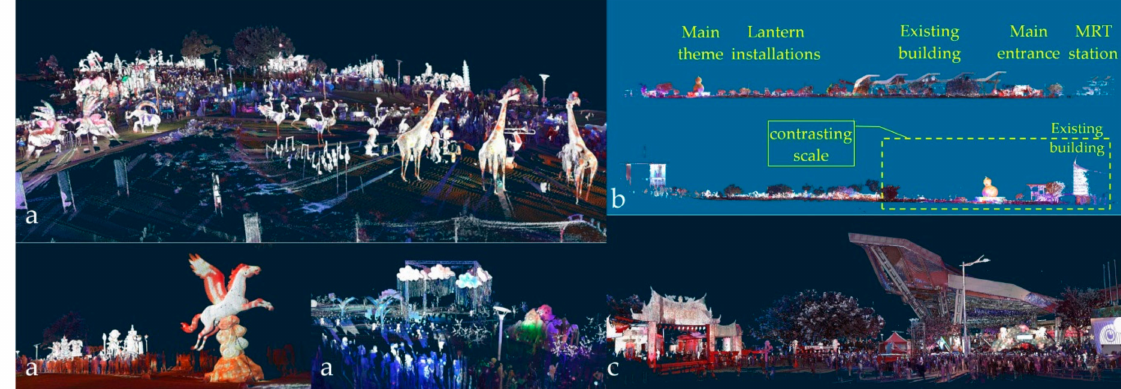
Figure 1. ( a ) The 2016 Taipei Lantern Festival with different types of installations; ( b ) the spatial structure; ( c ) the main entrance to the main theme lantern using the point cloud